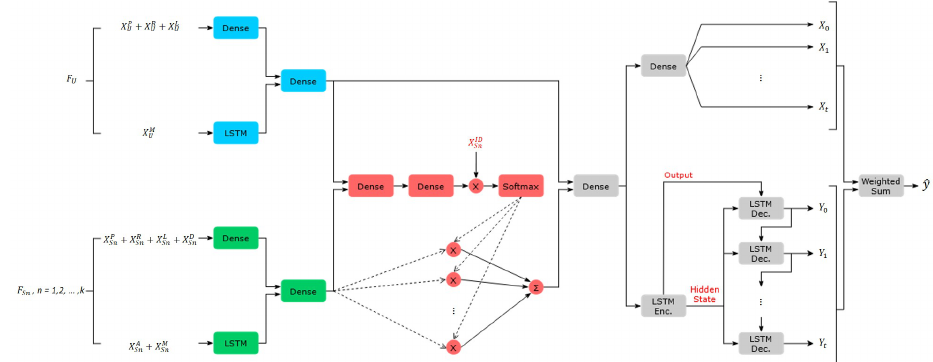
Figure 2. Technical data flows and components of the proposed framework. The color blue represents the data flows of unlabeled grid features. The color green represents the flows of labeled grid features. The color red represents the operations of inversed distance attention. The color grey represents the operations of the hybrid predictor.